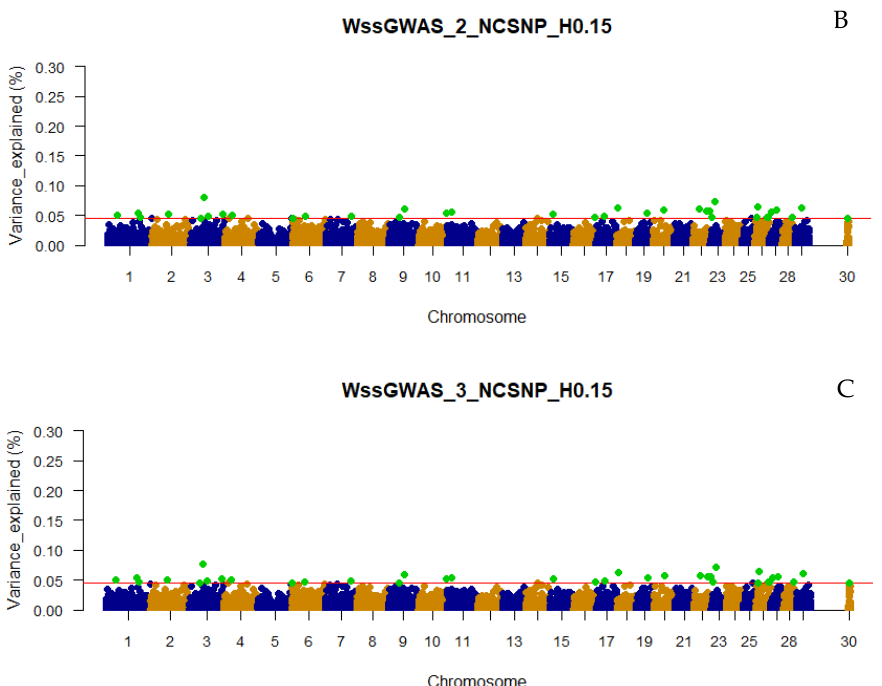
Figure 5. Manhattan plot of the percentage of the total additive genetic variance explained by non- clustered SNPs and haplotypes from haploblocks built with a linkage disequilibrium threshold of 0.15 for yearling temperament in American Angus cattle using single-step GWAS (ssGWAS_NCSNP_H0.15; A ) and weighted single-step GWAS in the second (WssGWAS_2_NCSNP_H0.15; B ) and third WssGWAS_3_NCSNP_H0.15; C ) iterations. Green points highlighted above the red horizontal line are the top 0.001% markers that explained greater percentages of the total additive genetic variance for YT. The X-chromosome (PAR region) is represented by the chromosome 30.